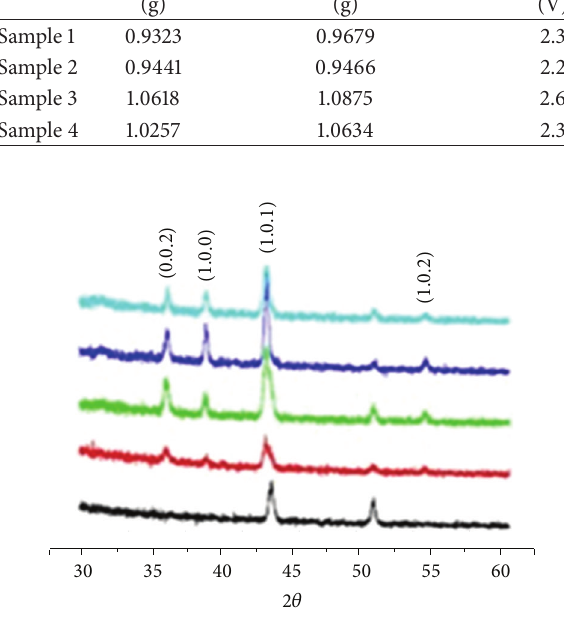
Figure 7: X-ray diffraction patterns of zinc metal precipitation by flowelectrolysis.(a)Background,black.(b)Sample1,red.(c)Sample 2, green. (d) Sample 3, blue. (e) Sample 4, light blue. (Unindexed peaks mean steel background signal.)